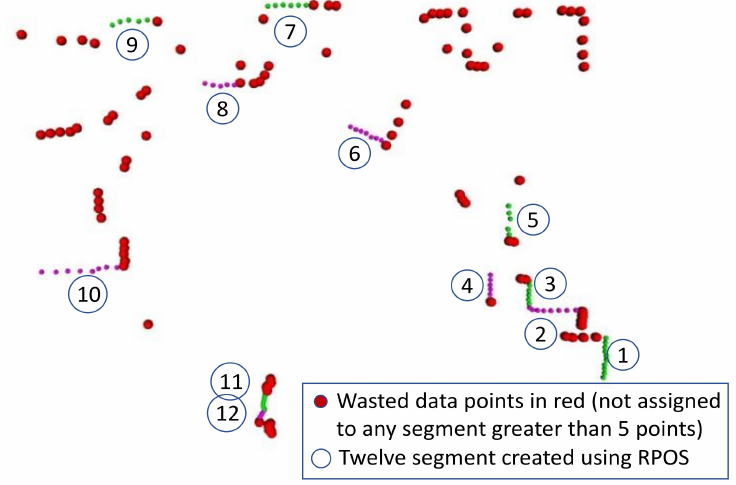
Figure 8. The relative position and orientation-based segmentation RPOS approach with red marks representing wasted datapoints, which are not part of any segment in the scan. A total of 12 green and purple segments were created by this approach. The green and purple colors are used to show the data points of two consecutive